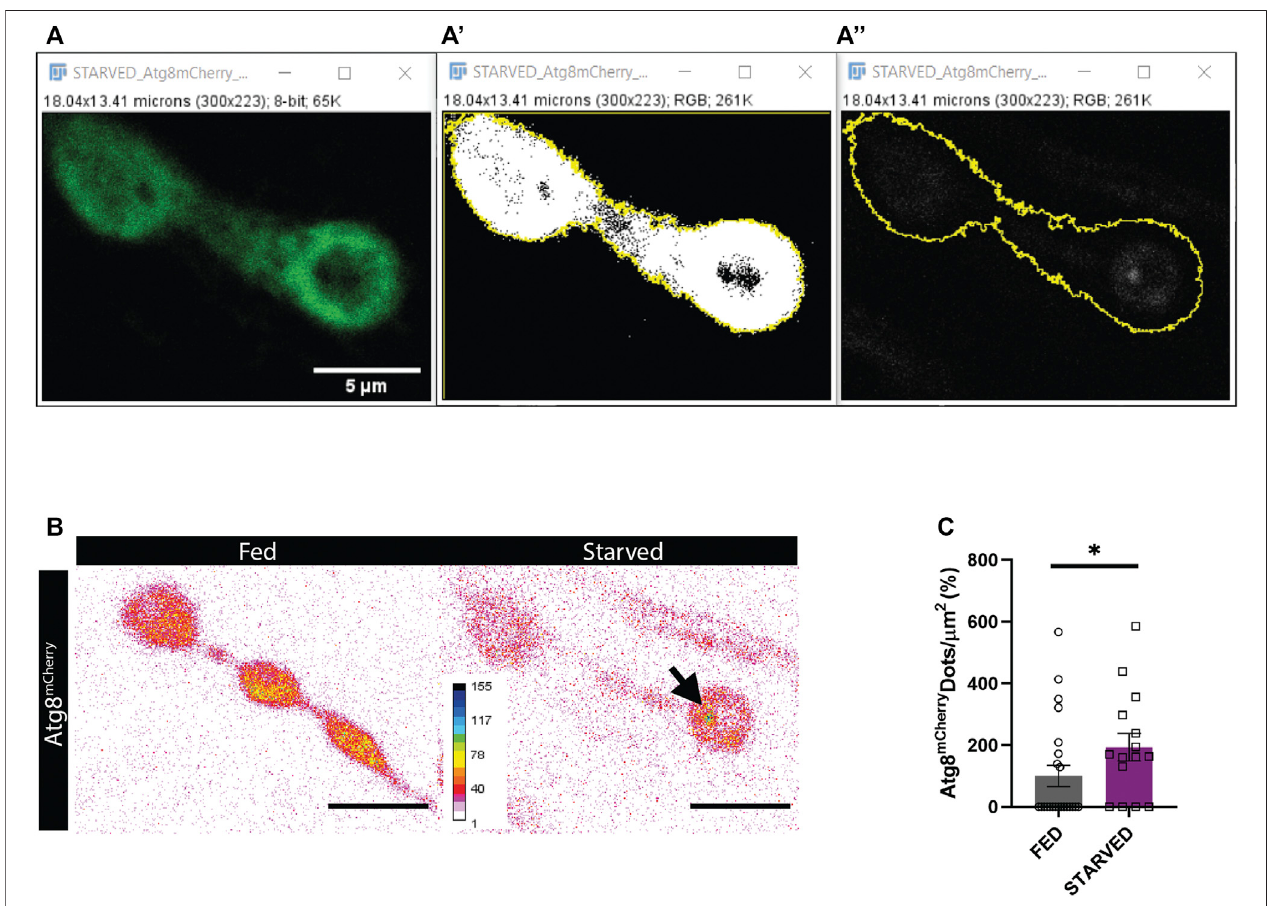
FIGURE 5| Results obtained using Autophagoquant macro. (A,B) NMJ boutons of Drosophila larvae expressing the autophagosome marker Atg8-mCherry (LC3 in mammals) under the control of the motorneuron promotor D42 (D42 -Gal4 > Atg8 mCherry ). (A) Confocal image of DLG staining and (A ’ ) threshold DLG signal to determine synapse outline. (A ’’ ) Confocal image of Atg8-mCherry signal with synapse outline in yellow obtained from thresholding the DLG signal. (B) Representative images of Atg8-mCherry signal are displayed in inverted 16 colors LUT for fed and starved condition. (C) Quanti fi cation with Autophagoquant shows that more autophagosomes are formed after starvation. Values were normalized to wildtype in the fed condition. n (cid:2) 22 (fed) and n (cid:2) 16 (starved) image fi elds per condition. Data were analyzed Mann-Whitney (two-tailed) for not normally distributed data. Normality was analyzed with D ’ agostino-Pearson Omnibus test * p < 0.05, data shown as mean ±